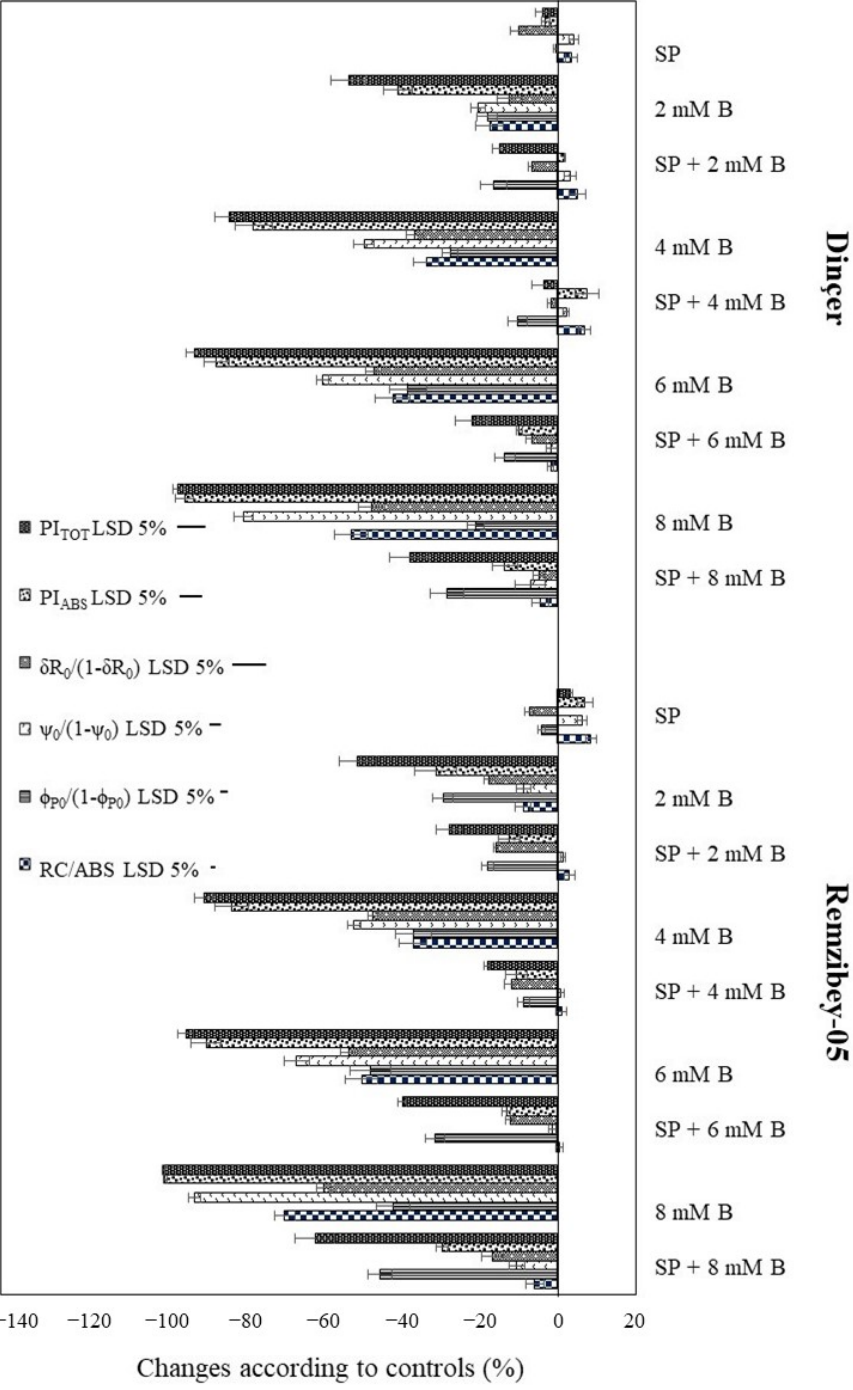
Figure 5. Changes in photosynthetic performance indexes (PI ABS and PI TOT ) and their components of safflower cultivars which were exposed to toxic B treatments with or without SP. PI TOT —total performance index; PI ABS —the performance index for the photochemical activity; δ R0 /(1 − δ R0 )—quantum yield of reduction of end electron acceptors at the PSI; Ψ 0 /(1 − Ψ 0 )—the ratio of electrons removed from the system and electrons accumulated in the system; ϕ P0 /(1 − ϕ P0 )—indicator of the effectiveness of primary photochemical reaction; RC/ABS—Q A reducing RCs per PSII antenna chlorophyll. Mean values of parameters were calculated as percentage of their corresponding controls, n = 6. The values are presented as the mean ± standard error (SE). The bars indicate significant difference between treatments and cultivars at p < 0.05 according to the LSD